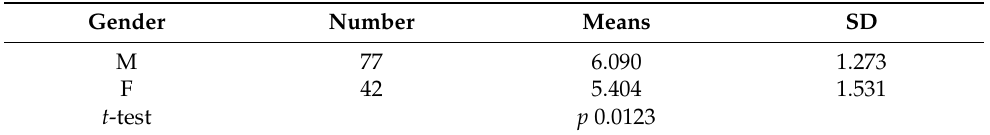
Table 4. Average values and standard deviation for the Corsi’s test score in ENS and TEAM volley, with respect to gender.